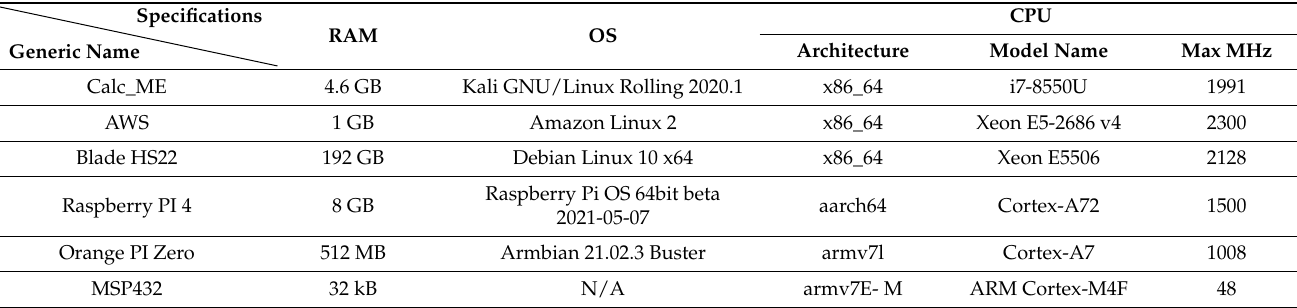
Table 1. Systems’ configuration used for testing the method.